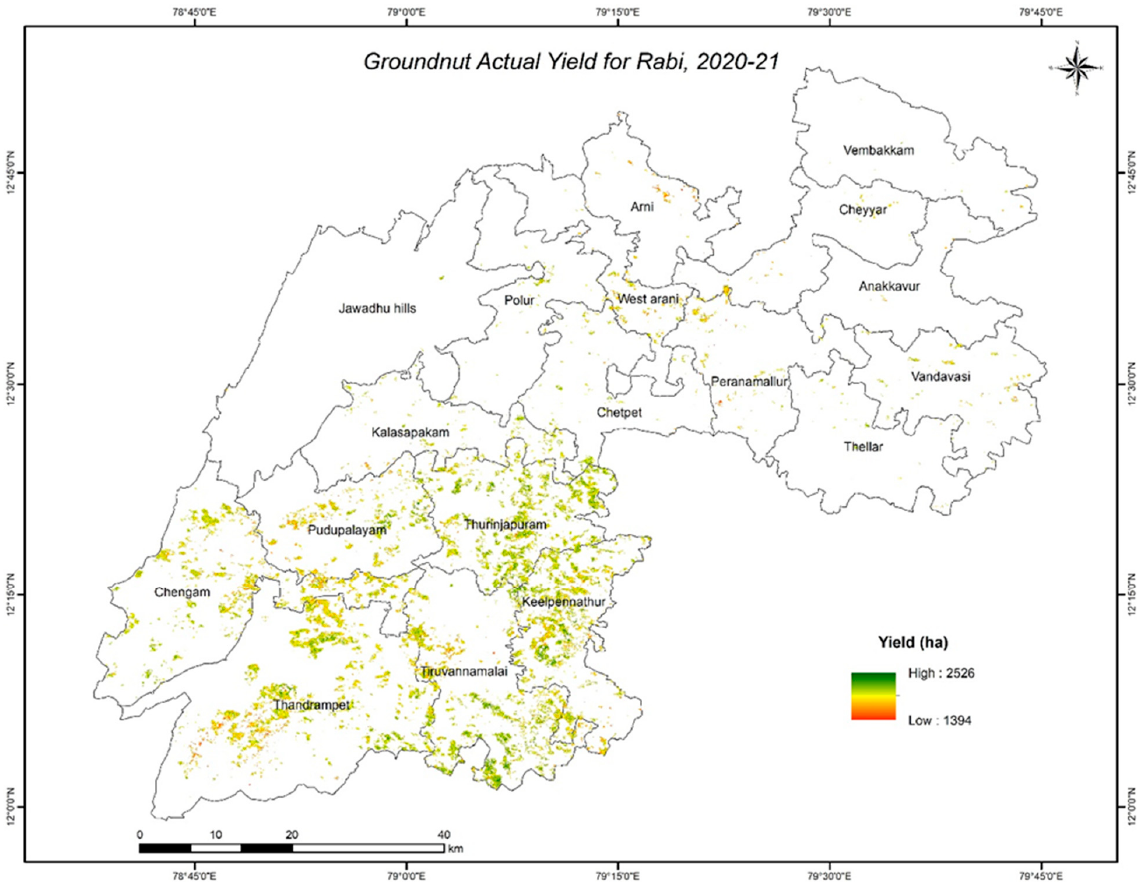
Figure 9. Spatial peanut actual yield of Tiruvannamalai district during Rabi 2020–21.